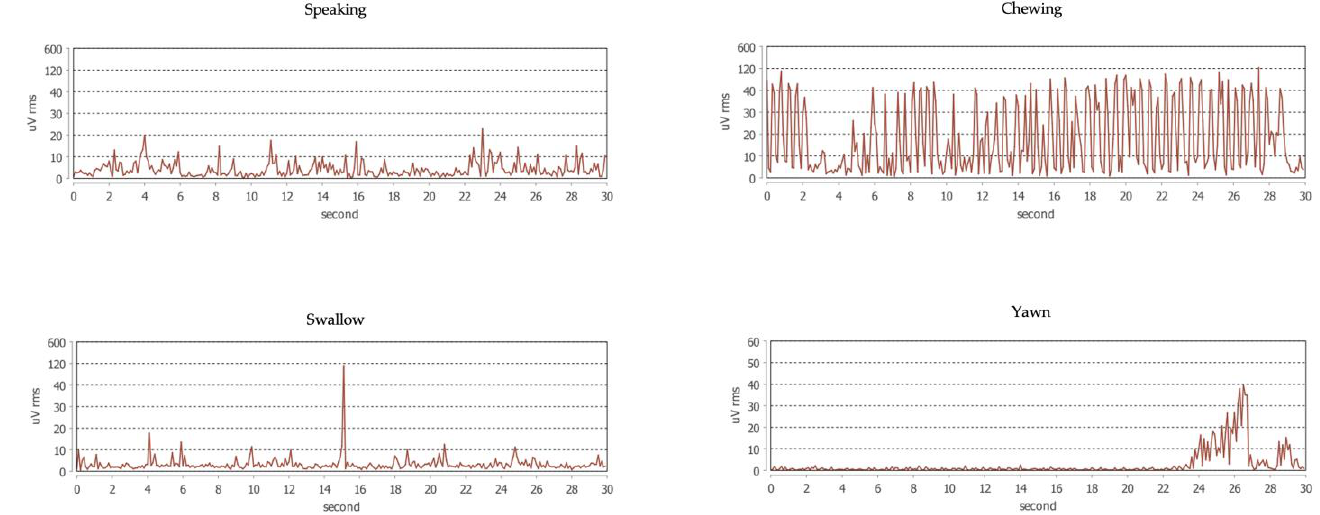
Figure 3. Example traces of physiological activities of the masseter muscle.